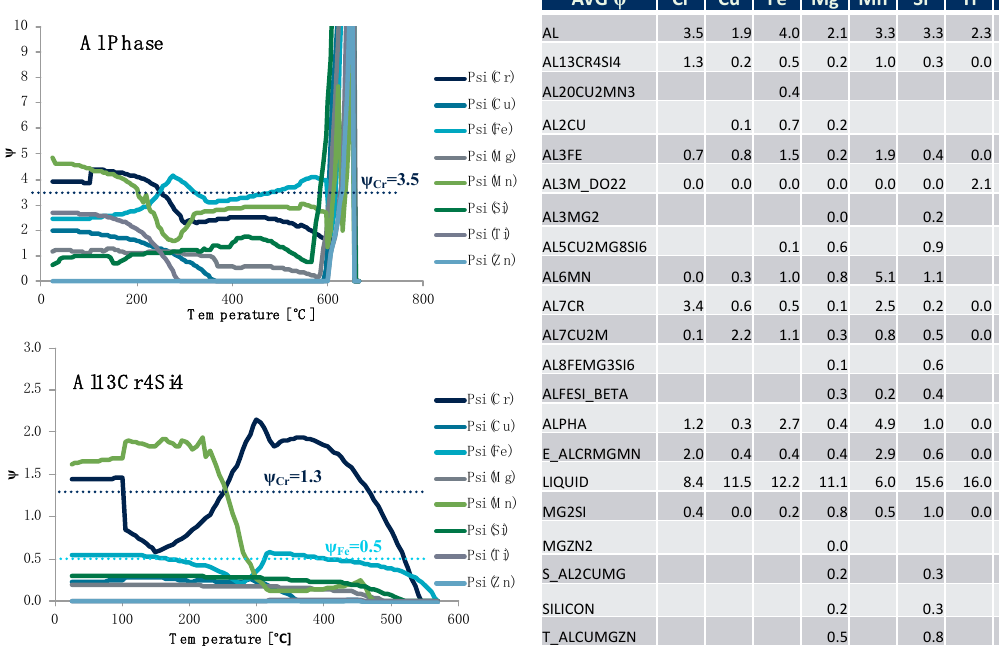
Figure 25. The 𝜓 s associated with each of the alloying elements for the matrix aluminum FCC matrix or base phase and the Al 13 Cr 4 Si 4 phase as a function of temperature. At the same time, a table presenting the average 𝜓 s computed for the particular phase–element combinations studied over the range of temperatures considered in silico is presented in Figure 25 as well.